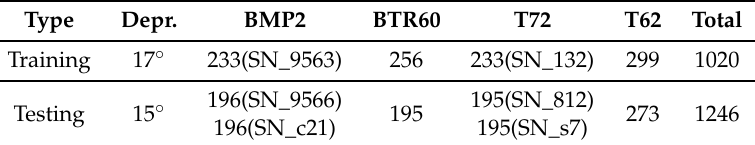
Table 1. The type and number of samples in different depression